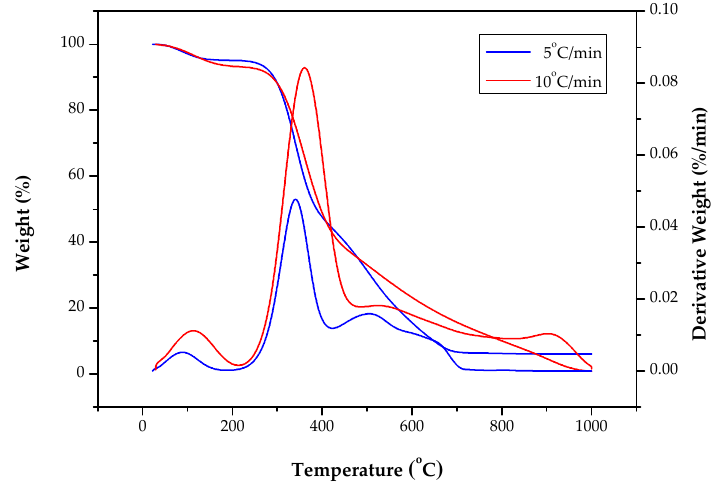
Figure 3. Thermogravimetric analysis/derivative thermogravimetry (TGA/DTG) curves of pre- treated RH sample (i.e., RH-25) at the heating rates of 5 °C/min and 10 °C/min.